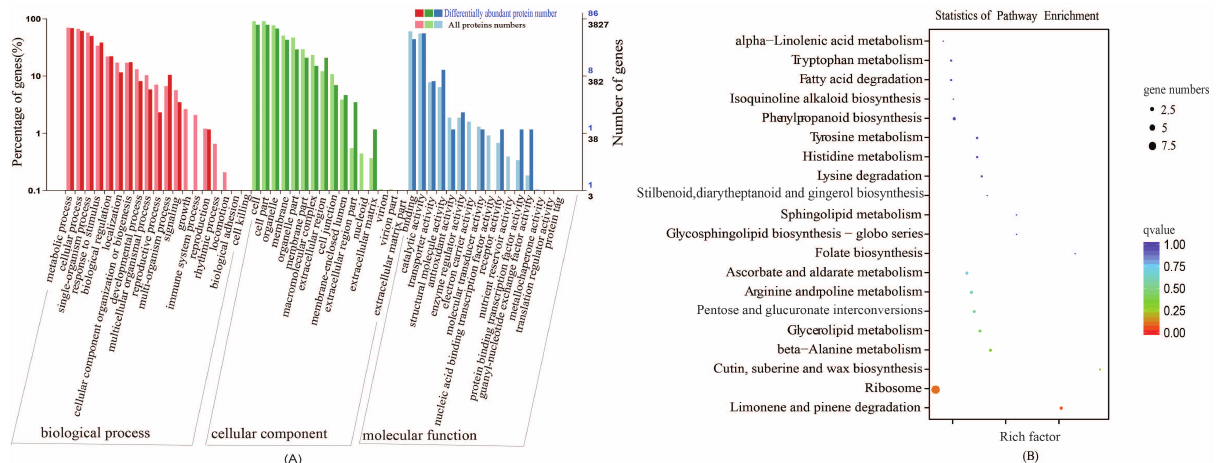
Figure 4. The functional annotation of differentially expressed protein under the +S and –S Treatment. ( A ) and ( B ) represent GO annotation and Kyoto Encyclopedia of Genes and Genomes (KEGG) pathway enrichment, respectively. Enrichment factor represents the ratio of genes annotated to the pathway of differential genes to the ratio of all genes annotated to the pathway. Enrichment factor indicates that the enrichment level of differential genes in the pathway is more significant. p -value after the correction for multiple hypothesis testing q -value is, the smaller the q -value represent a significant enrichment of the more